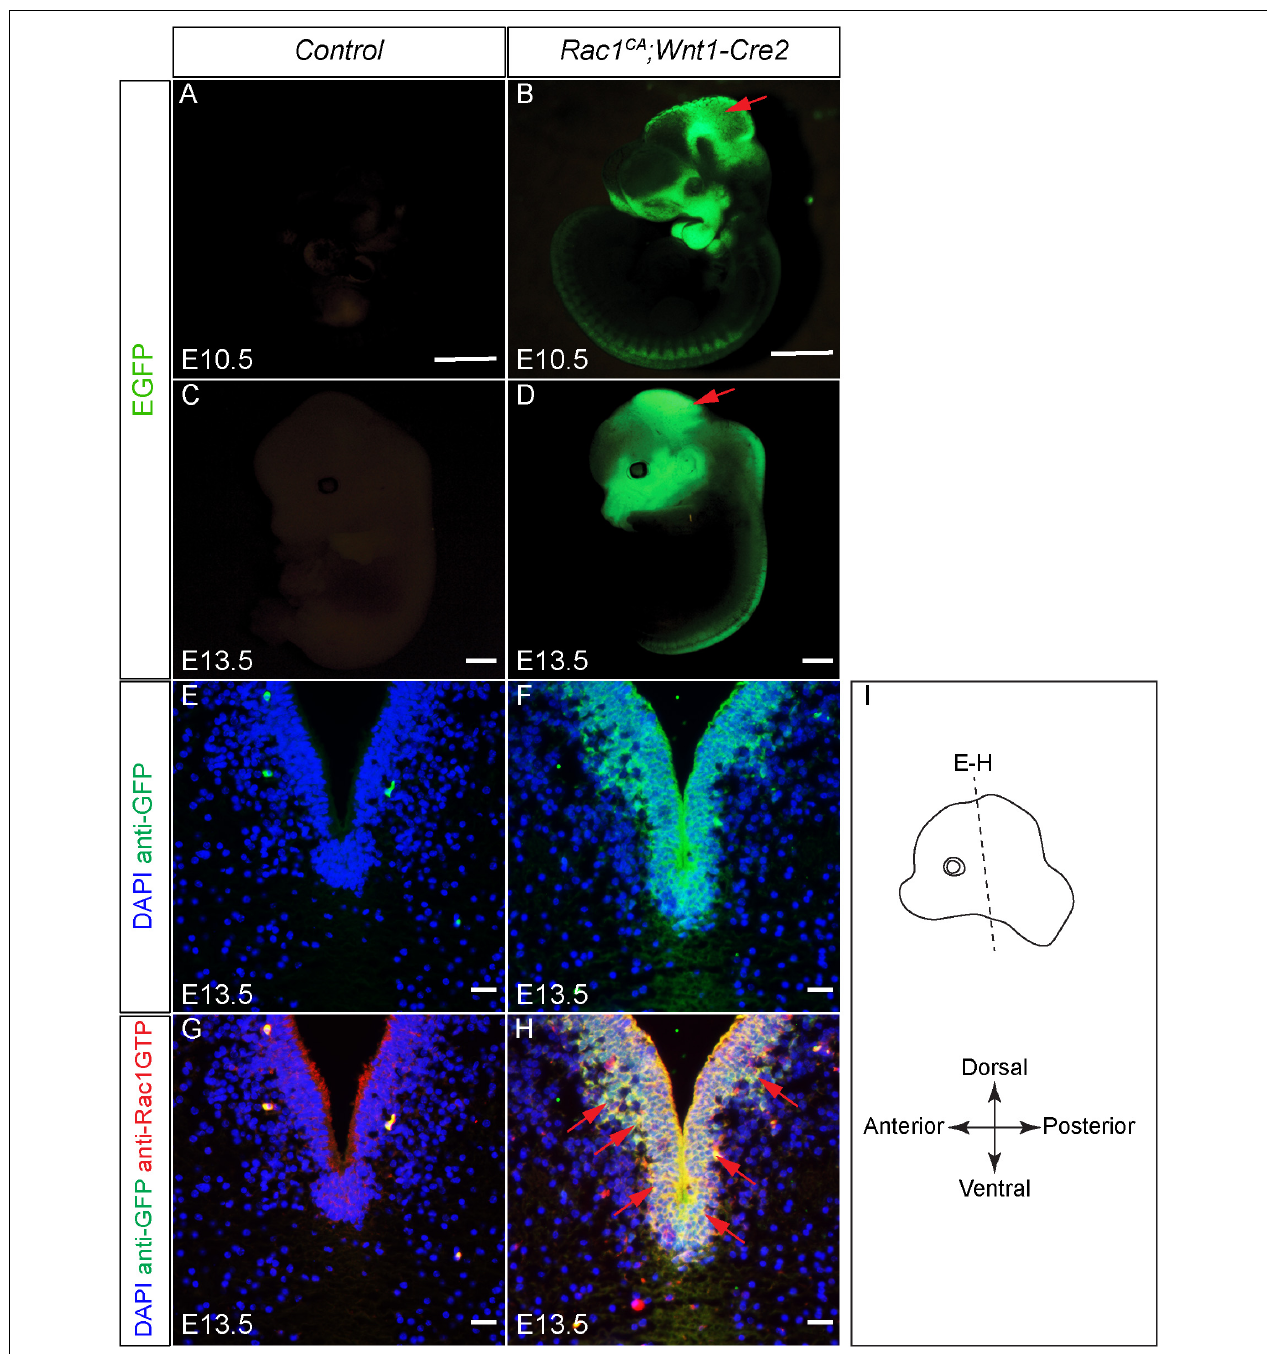
FIGURE 1 | Validation of augmented Rac1 activity in Rac1 CA ;Wnt1-Cre2 embryos. (A–D) Whole-mount view of the control (A,C) and Rac1 CA ;Wnt1-Cre2 (B,D) embryo at E10.5 (A,B) and E13.5 (C,D) . (E,F) Immunostaining with anti-GFP antibody (green) on coronal sections of the control (E) and Rac1 CA ;Wnt1-Cre2 (F) at the level of ventral midbrain at E13.5. Slides are counterstained with DAPI (blue). (G,H) Co-immunostaining with anti-Rac1-GTP antibody (red) and anti-GFP antibody (green) on coronal sections of E13.5 littermate control (G) and Rac1 CA ;Wnt1-Cre2 (H) at the level of ventral midbrain. Slides are counterstained with DAPI (blue). Red arrows point to overlapped expression of EGFP and Rac1-GTP. (I) Illustration of the embryo orientation and section level in figure and following figures. Scale bar in A–D , 1 mm. Scale bar in E–H , 10 µ m.